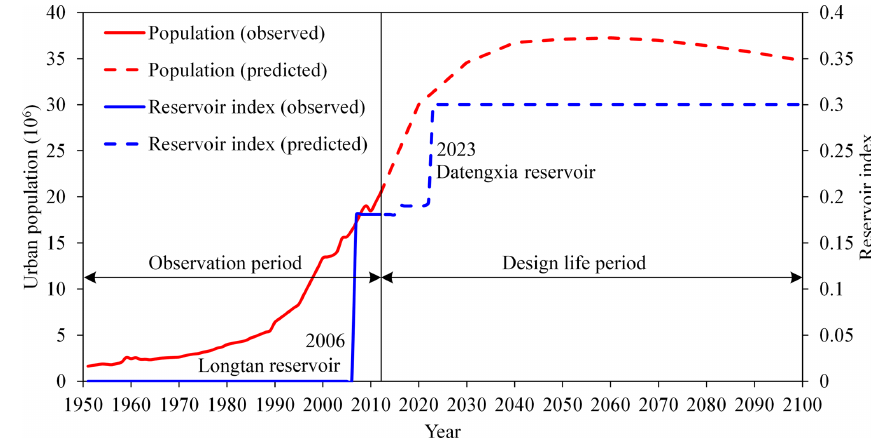
Figure 2. Evolution of the urban population and reservoir index during both the observation and design life